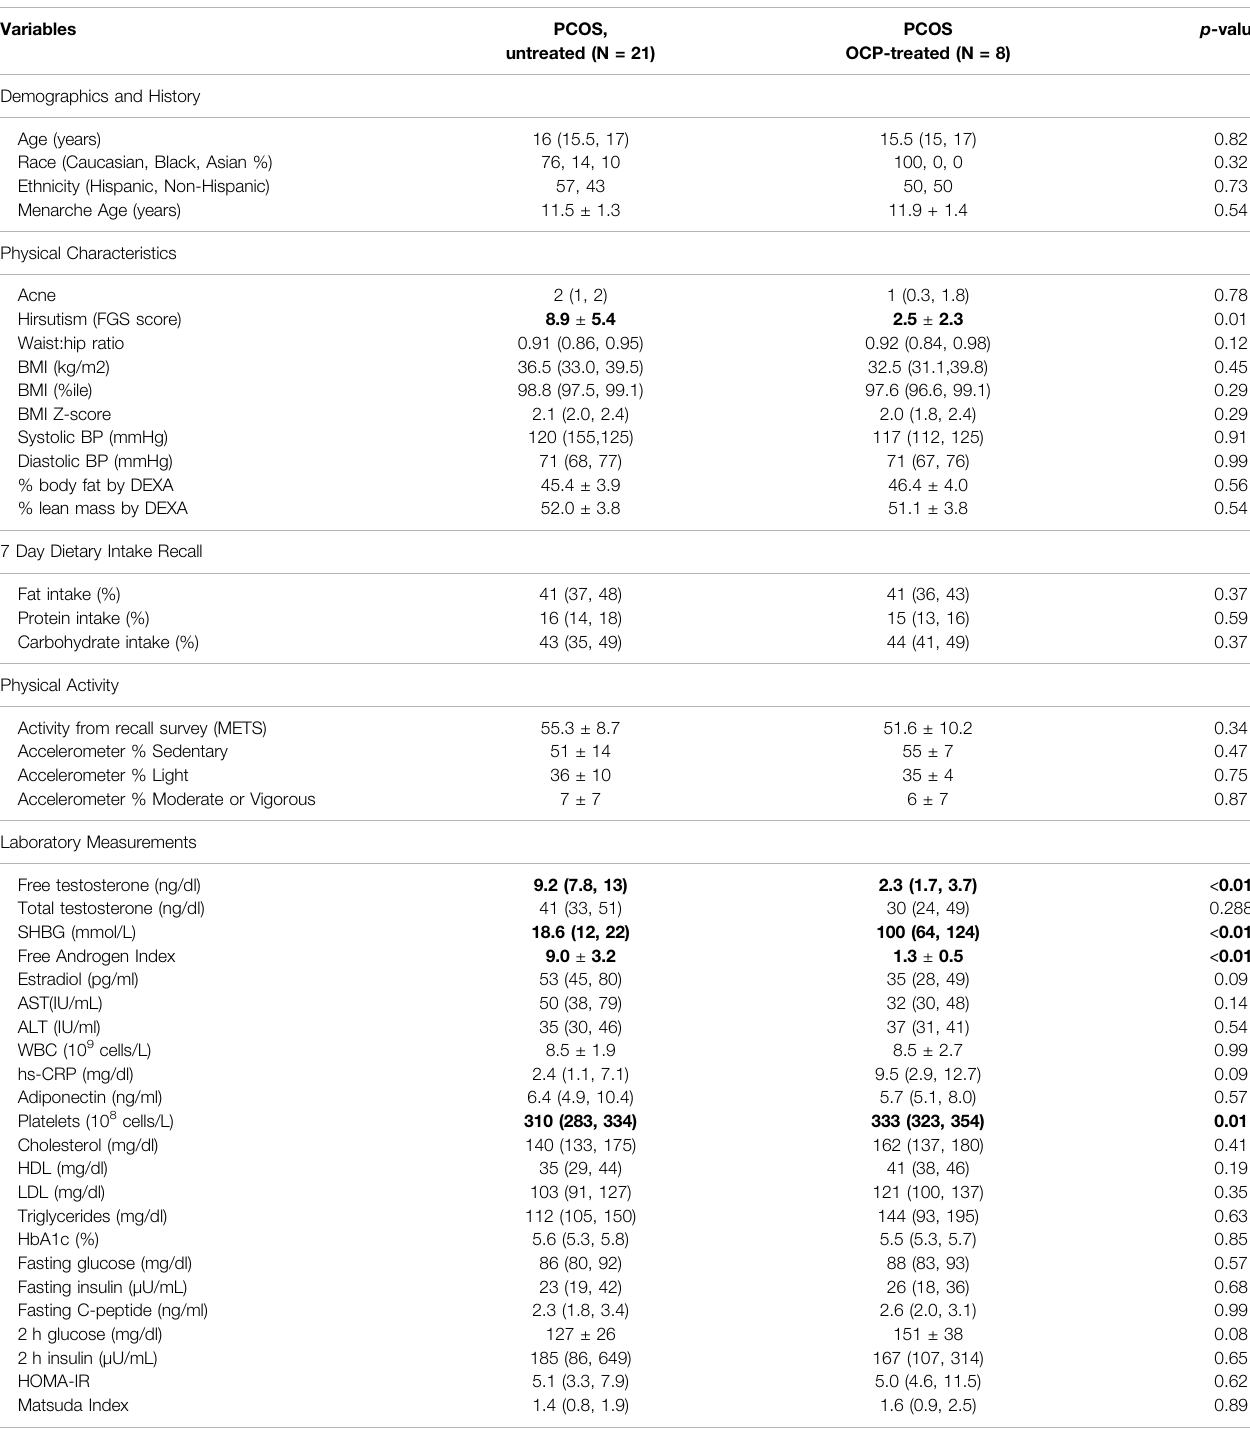
TABLE 1 | Participant demographic, physical characteristics and laboratory measurements comparing girls with obesity and PCOS with (N = 8) and without (N = 21) oral contraceptive treatment. PCOS untreated had signi fi cantly higher hirsutism score, free testosterone, and free androgen index and lower SHBG and platelets. All other variables were similar between